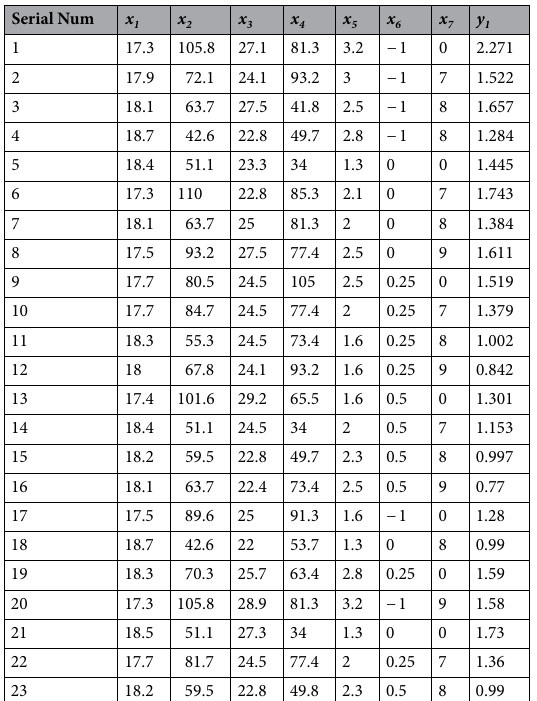
Table 1. Sample data of loess slopes (Gao et al. 34 ). x 1 , x 2 , x 3 , x 4 , x 5 , x 6 , x 7 and y 1 are the density, cohesion, internal friction angle, slope height, slope ratio, pore water pressure coefficient, seismic intensity and safety factor, respectively.